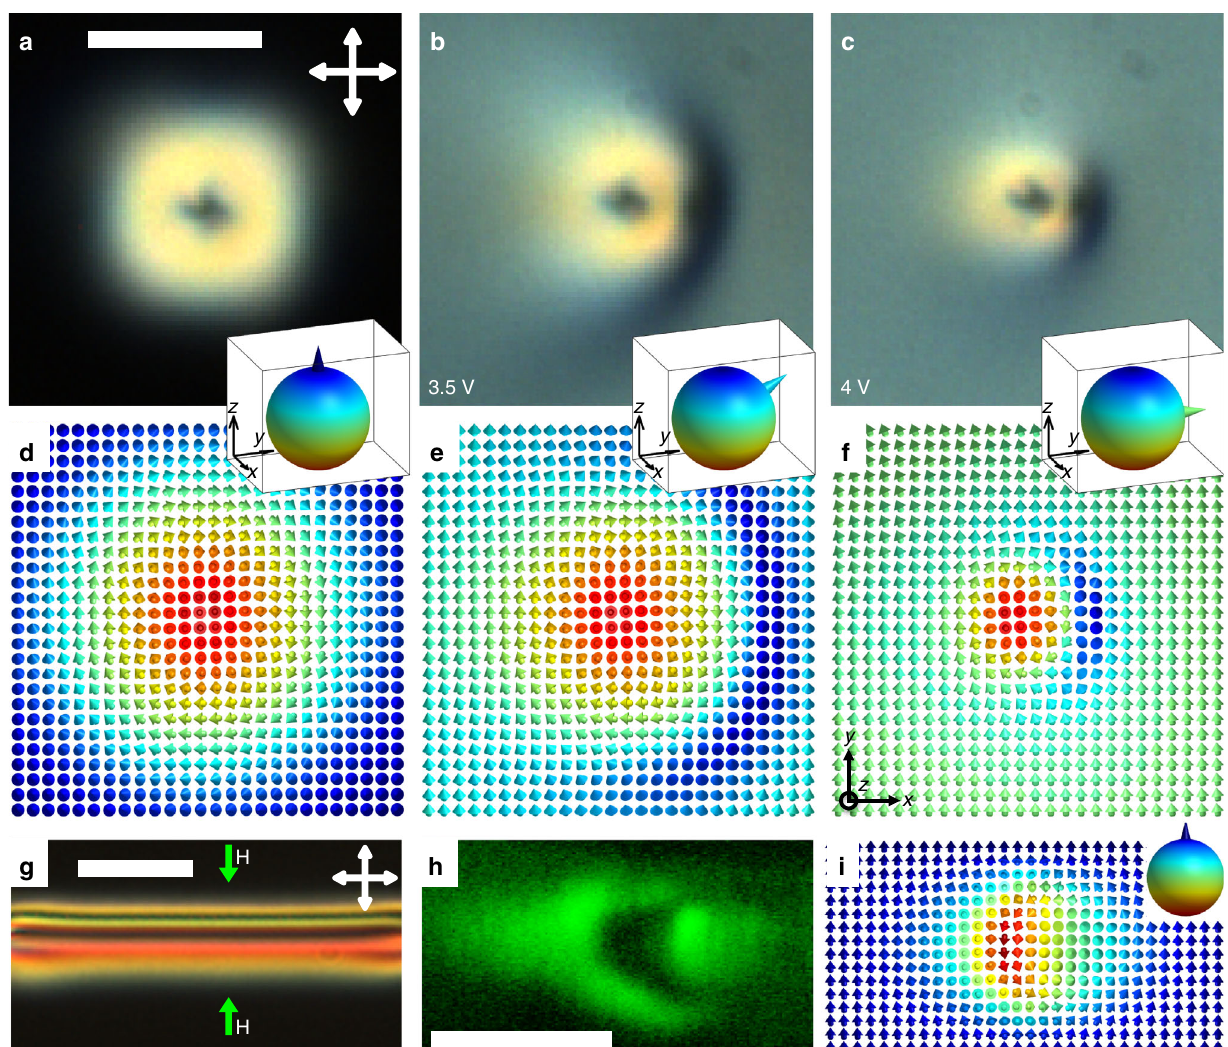
Fig. 2 Topology and electric switching of baby skyrmions. a – c POM micrographs of a skyrmion at ( a ) no applied fi elds and ( b , c ) at voltages indicated on images, the scale bar is 10 µ m. Crossed polarizers used to obtain POM micrographs ( a – c ) are shown using white double arrows in ( a ). f c = 1 kHz. d – f Computer-simulated vectorized n ( r )-con fi gurations corresponding to ( a – c ), where n ( r ) is shown using arrows colored according to their orientations and corresponding points on the S 2 -sphere (insets), with the orientation of n 0 on S 2 shown using cones. g POM micrograph of a baby skyrmion in a glass cell with perpendicular boundary conditions. The scale bar is 20 µ m. h Polarized nonlinear optical image of the skyrmion ’ s 2D plane containing n 0 . The image was obtained in the vertical cross-section along the H-H line of g . The scale bar is 10 µ m. i The computer-simulated n ( r ) corresponding to ( h ); computer-simulated analogs of images ( g , h ) are shown in the Supplementary Fig.